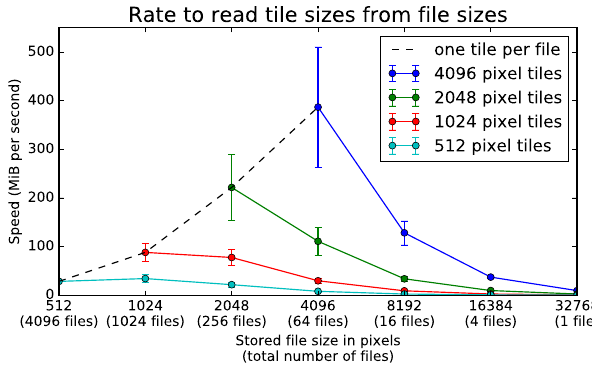
Figure 12. Rate to read various tile sizes from several file sizes. A server loads all tiles from an image stored on a network file system at a rate given by the number of separate TIFF files used to store the data. The server can use square tiles of variable area to load the full section of 32,768 × 32,768 pixels. The four different colored lines represent square tiles of length 512, 1024, 2048, and 4096. The negative slopes of all solid lines show loading speed decreases with larger files for any given tile dimensions. For any tile size above 512 pixels, the tiles load the fastest from files of the same size. The black dotted line shows that it is most efficient to read an entire file in a single section. Error bars represent